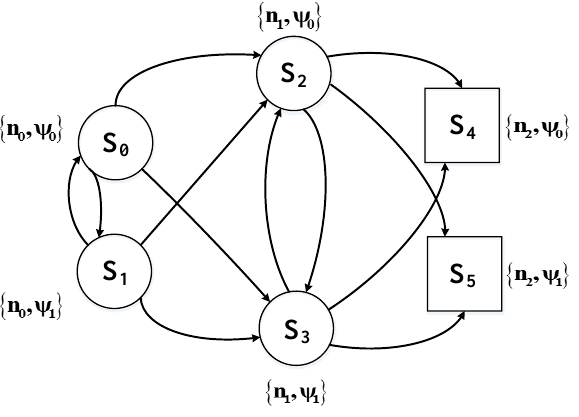
Figure 3. State Transition Diagram of the Markov Decision Process.